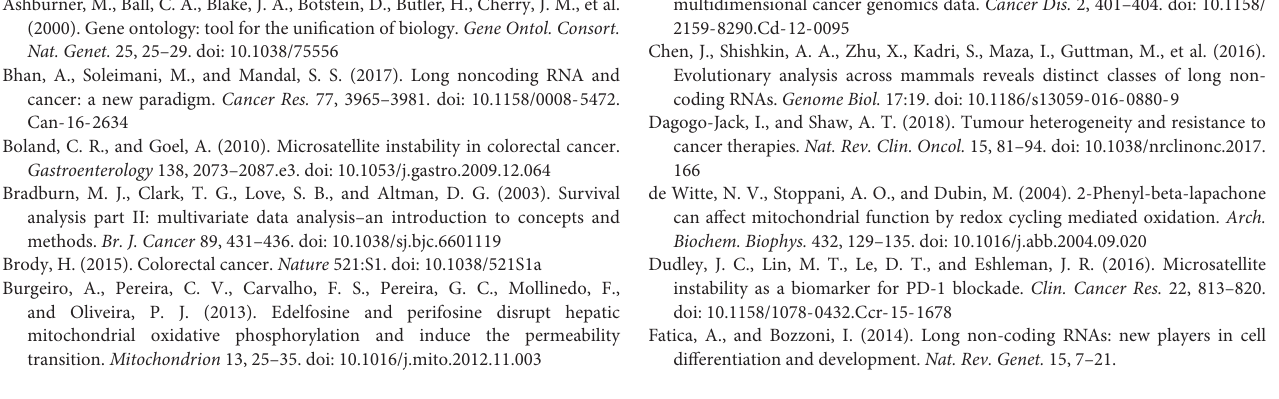
Supplementary Figure 2 | Supplemental gene correlation analysis of the three lncRNAs ( BOLA3-AS1 , AC124067.4 , and AL161772.1 ) and four target mRNAs